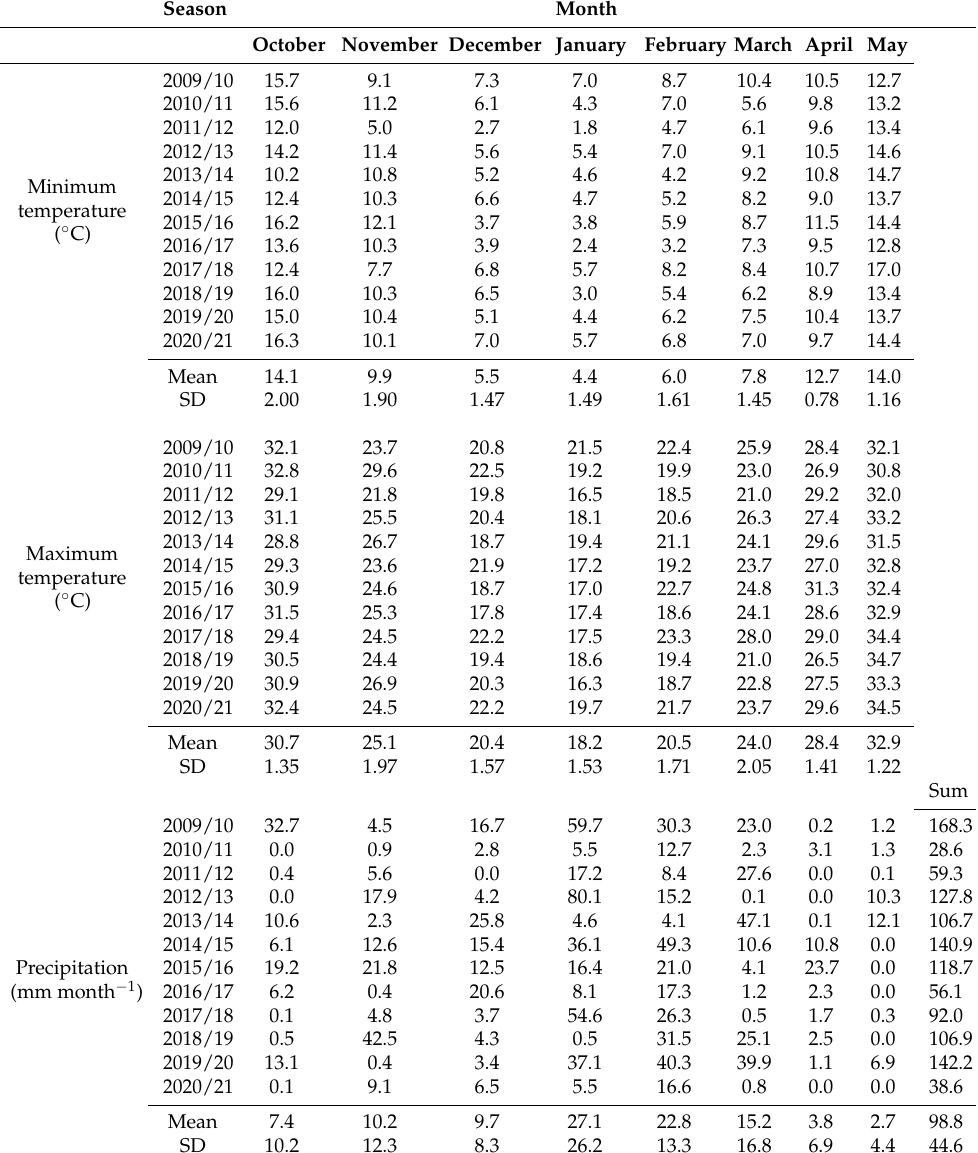
Table 2. Monthly mean minimum and maximum temperature, and monthly precipitation recorded at RNDARC during the recent 12 HSB growing seasons from October to